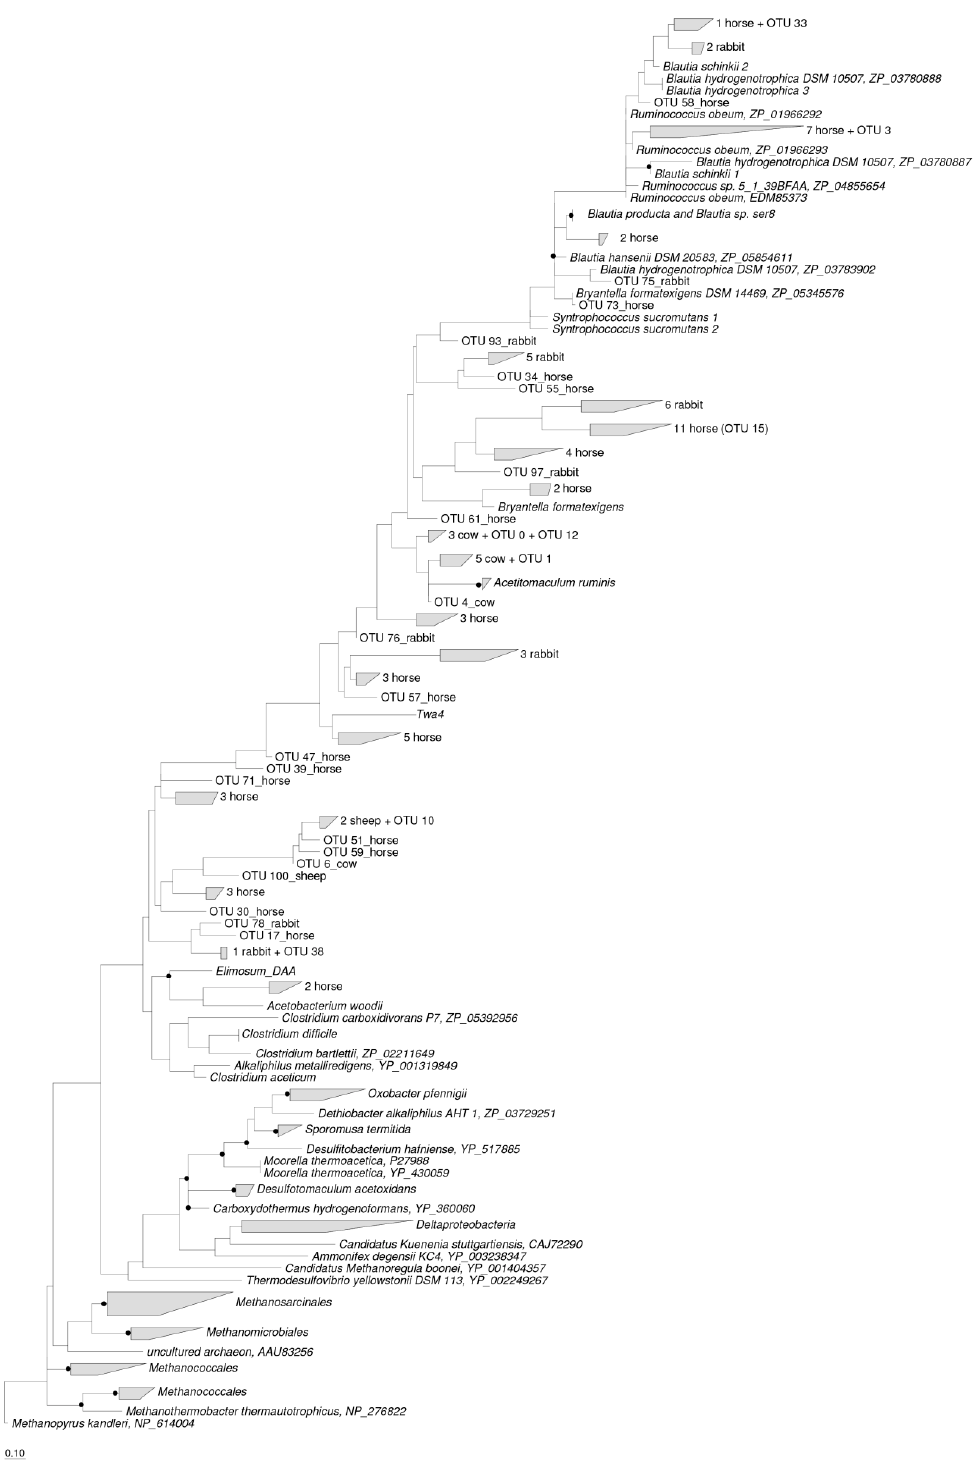
Figure 4. Phylogenetic analysis of deduced ACS amino acid sequences presented in the rumens of cows and sheep, the ceca of rabbits, and the feces of horses with reference ACS sequences (GenBank accession numbers were shown after the species names). Bootstrap values of ≥ 75% were shown at nodes as closed circles. The scale bar represents 10% sequence divergence. The number of ACS OTUs that presented in the rumens of cows and sheep, the ceca of rabbits and the feces of horses, as well as the dominant OTUs, which were indicated in brackets.